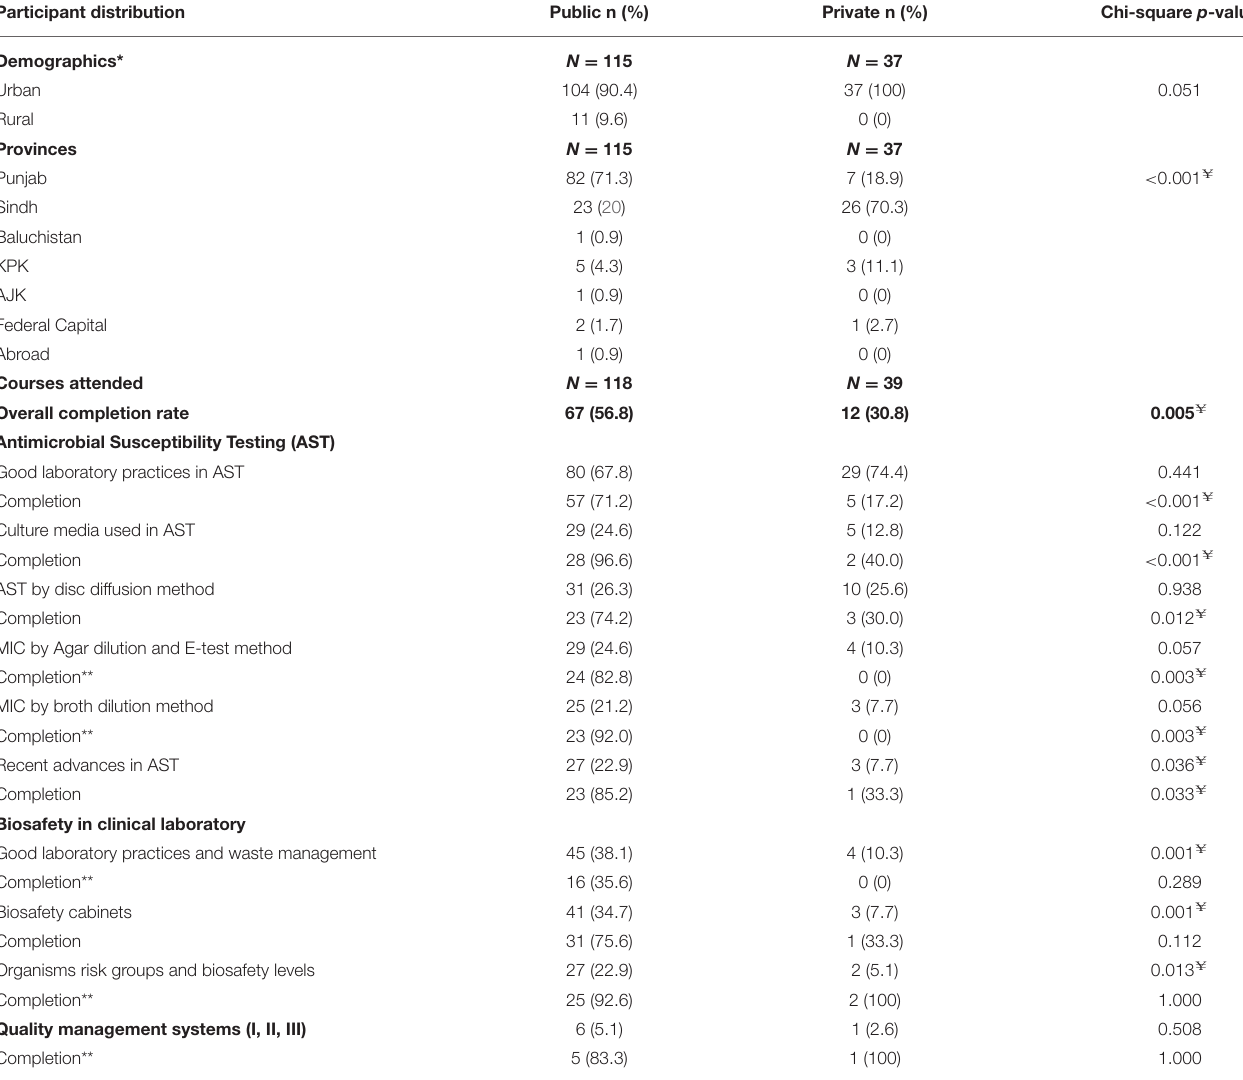
TABLE 3 | Open online course (OOC) penetration and completion across public and private sectors: details of 157 participants working in laboratories in Pakistan. Participant